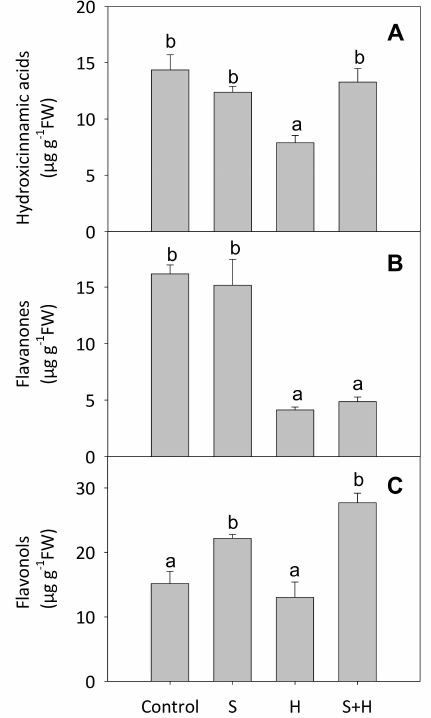
Figure 3. Concentration of hydroxycinnamic acids ( A ) flavanones ( B ) and flavonols ( C ) ( µ g g − 1 fresh weight) in tomato fruits under control (C), saline (S) and heat conditions (H) or the combination of salinity and heat (S + H). Values are means ± SE ( n = 6). Different letters indicate significant differences between means according to Duncan’s test at the 5% level.